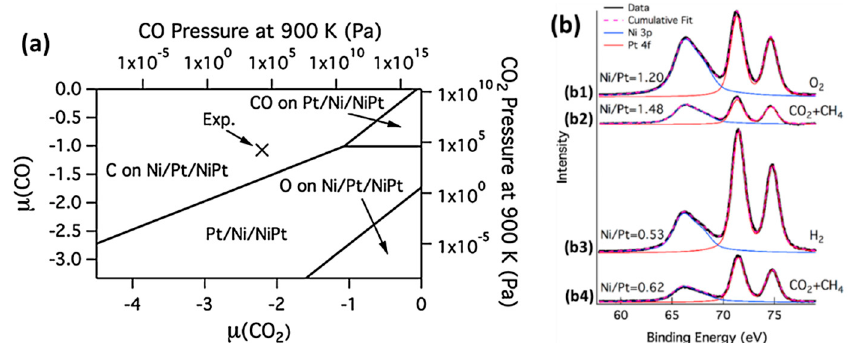
Figure 18. ( a ) Bimetallic NiPt surface phase diagram as a function of the chemical potentials of CO ( μ (CO)) and CO 2 ( μ (CO 2 )). “X” represents chemical potentials under true reactive DRM conditions, assuming atmospheric total pressure. ( b ) NAP-XPS spectra for a Ni-Pt crystalline surface ( b1 ) exposed to O 2 (4.3 × 10 − 5 Pa pressure) for 30 min at 227 °C; ( b2 ) subsequently annealed up to 250 °C in an equimolar mixture of CO 2 and CH 4 (P tot = 130 Torr); ( b3 ) subsequently annealed to 400 °C in H 2 (4.3 × 10 − 5 Pa pressure); and ( b4 ) subsequently annealed to 300 °C in an equimolar mixture of CO 2 and CH 4 (130 Torr total pressure). Reprinted with permission from Ref. [262]. Copyright 2015 Elsevier.